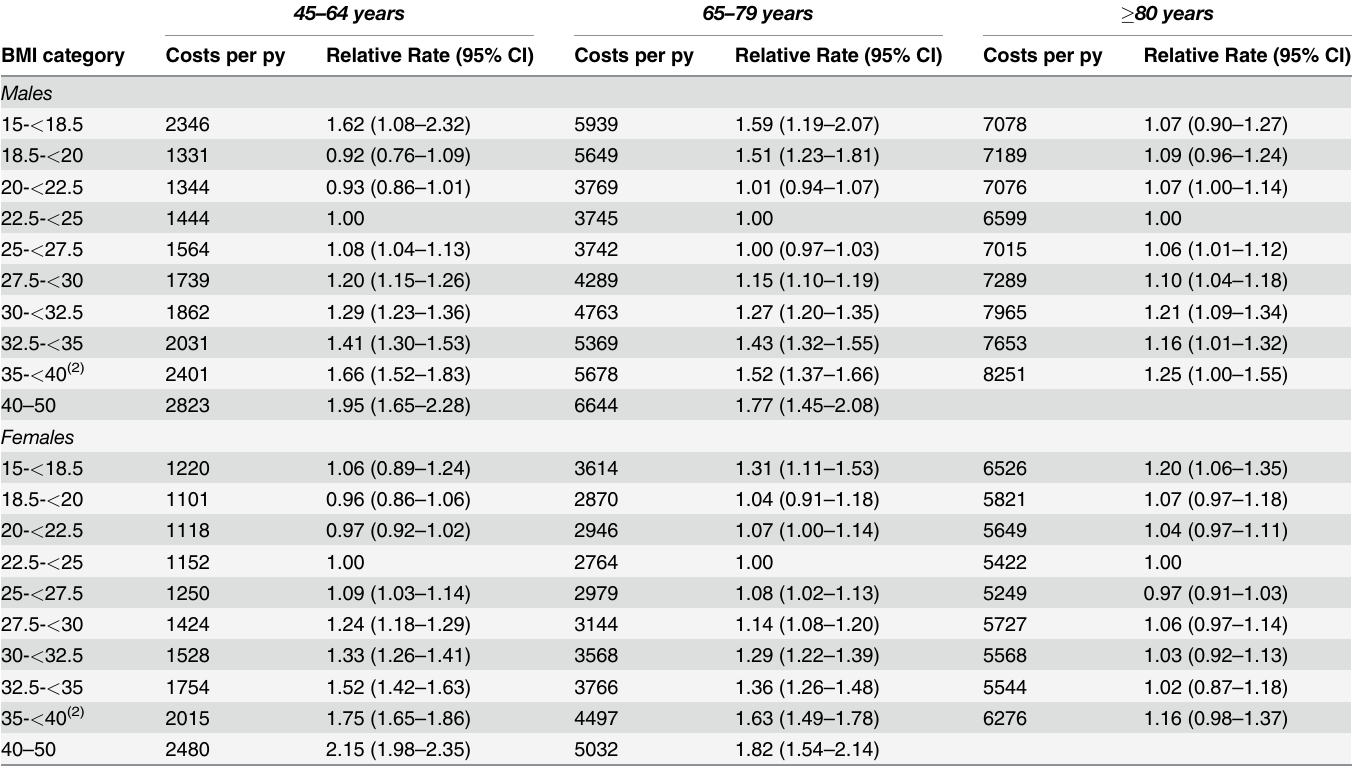
Table 4. Estimated hospital costs per person year, by body mass index (BMI) (1) .